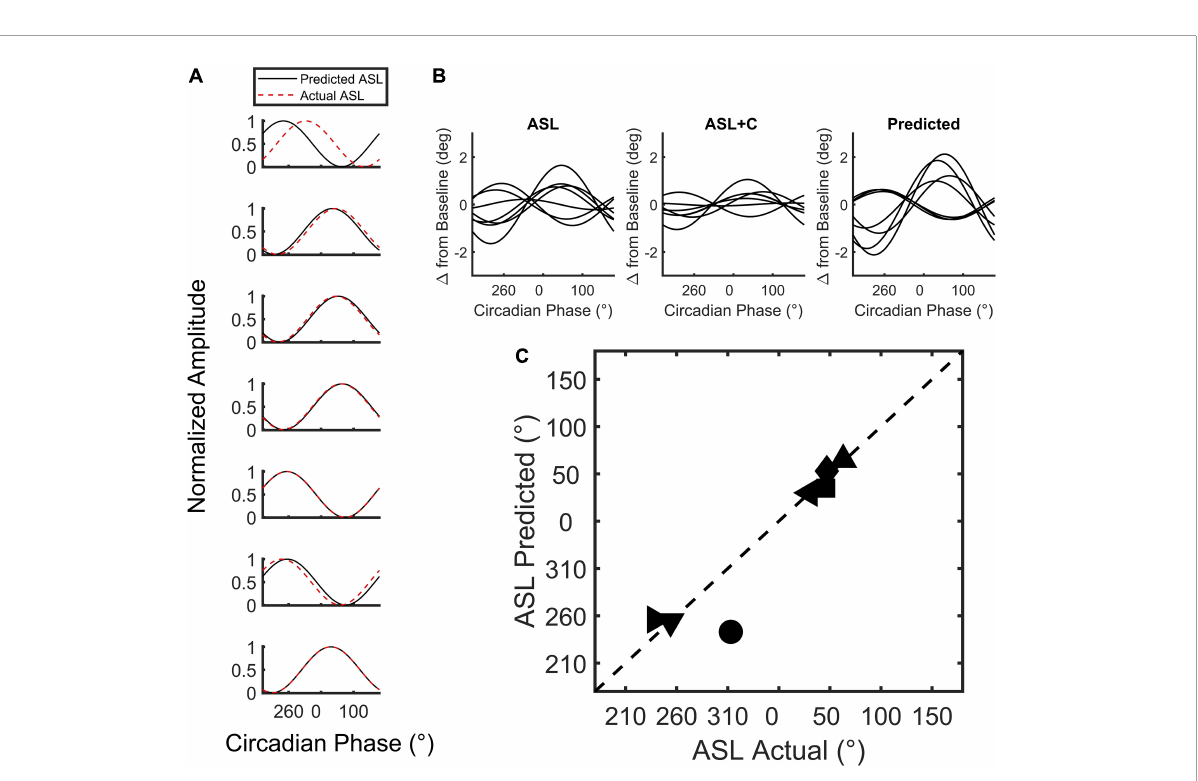
FIGURE7 Simulation of circadian phase variability in ground recouped during ASL. (A) Plot of the min-max normalized cosine fits of the predicted (red) and actual (black) ASL modulation for all seven subjects tested. (B) The unnormalized best-fit modulation of the seven subjects for the actual and predicted ASL. Note that the modulation phase of the prediction qualitatively resembles the actual modulation of the ASL data with one exception. (C) Two-dimensional scatterplot of predicted versus actual circadian phase with each point depicting a